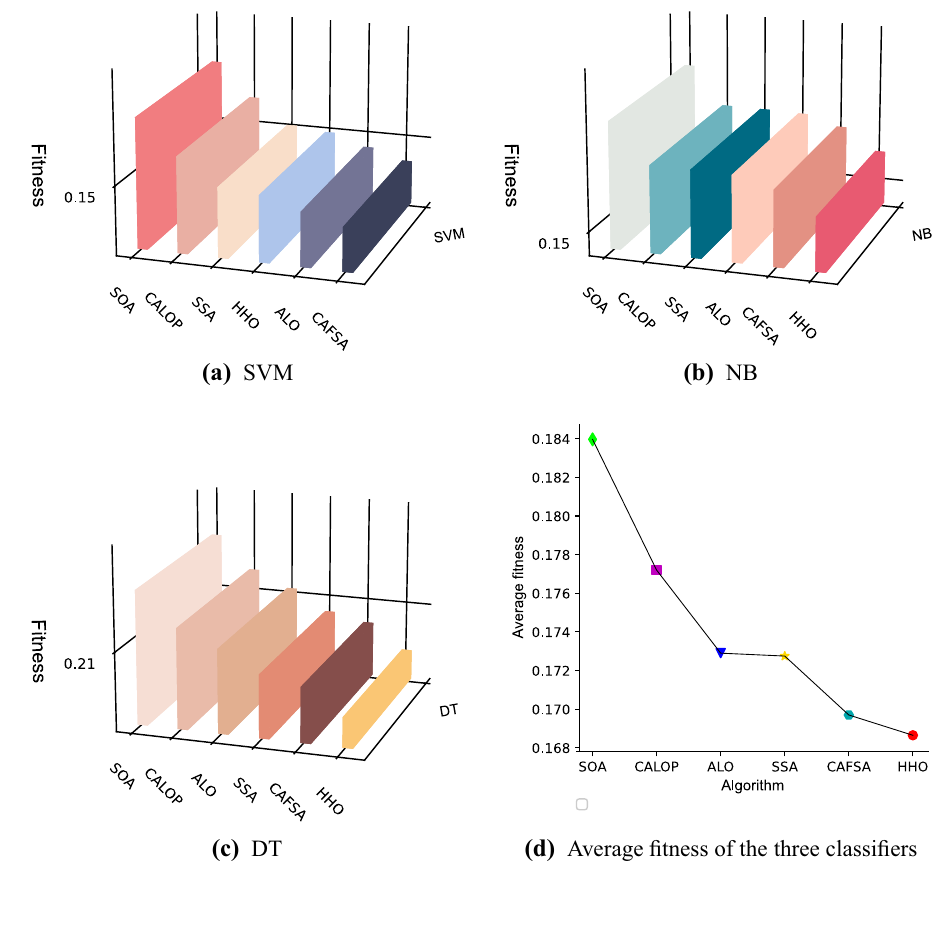
Table 9 Experimental results of six intelligent algorithms on the ChnSenticorp_Hotel data